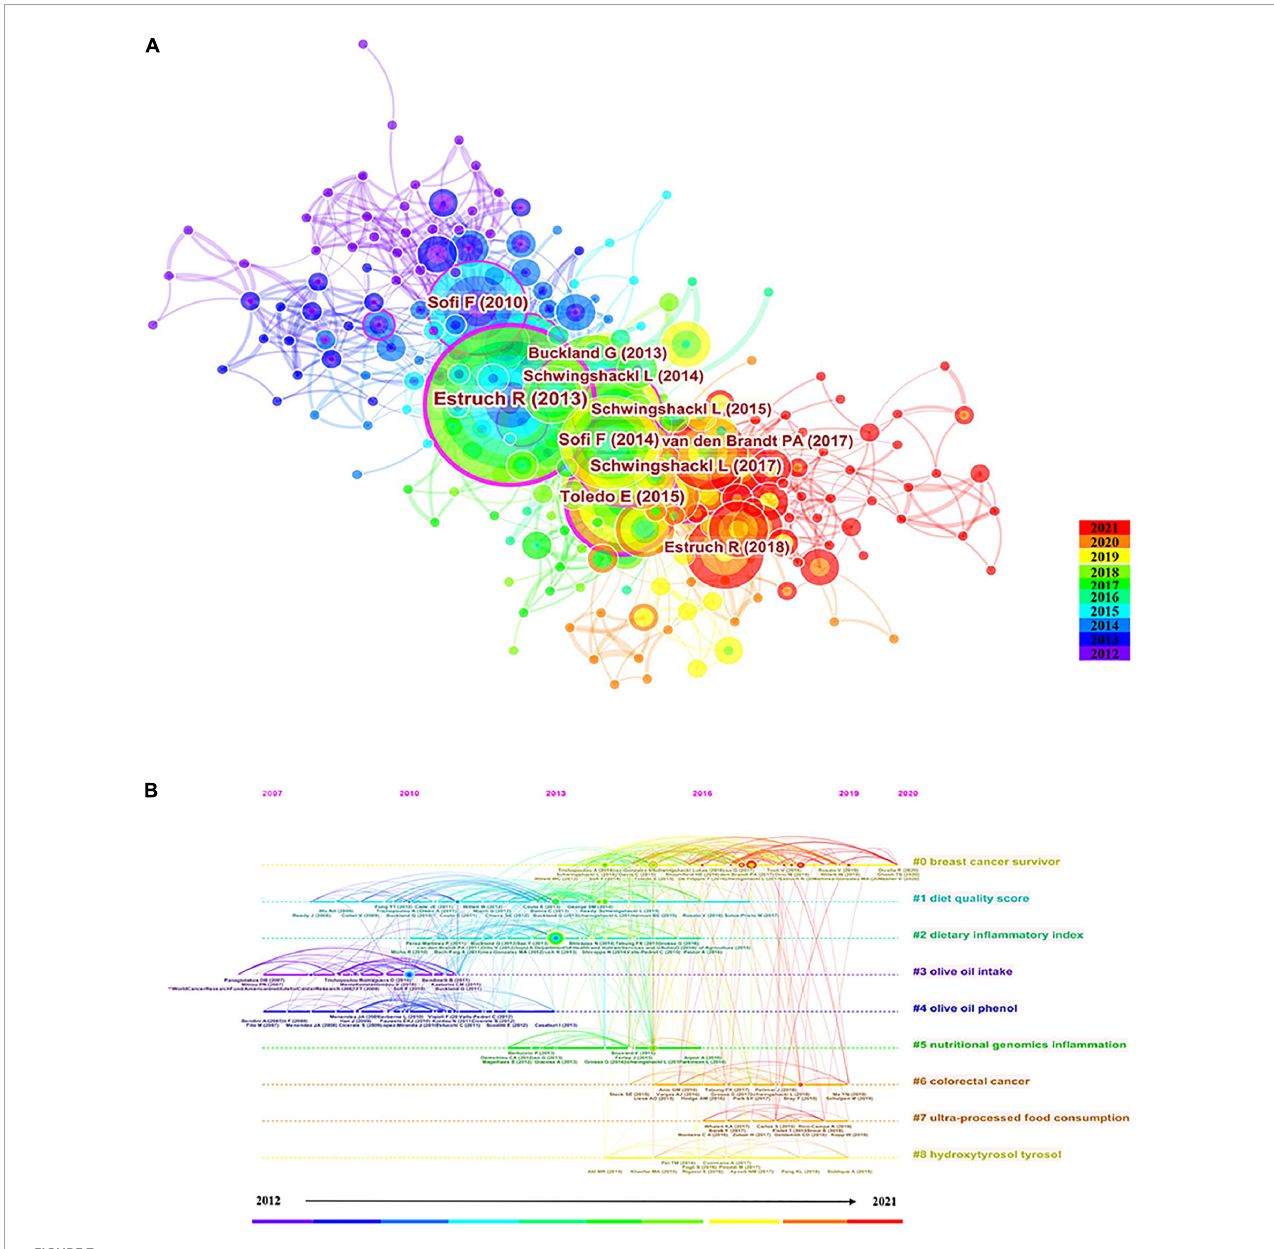
FIGURE7 (A) The co-occurrence map of references. (B) The timeline plot of references. The texts on the right are the topics.